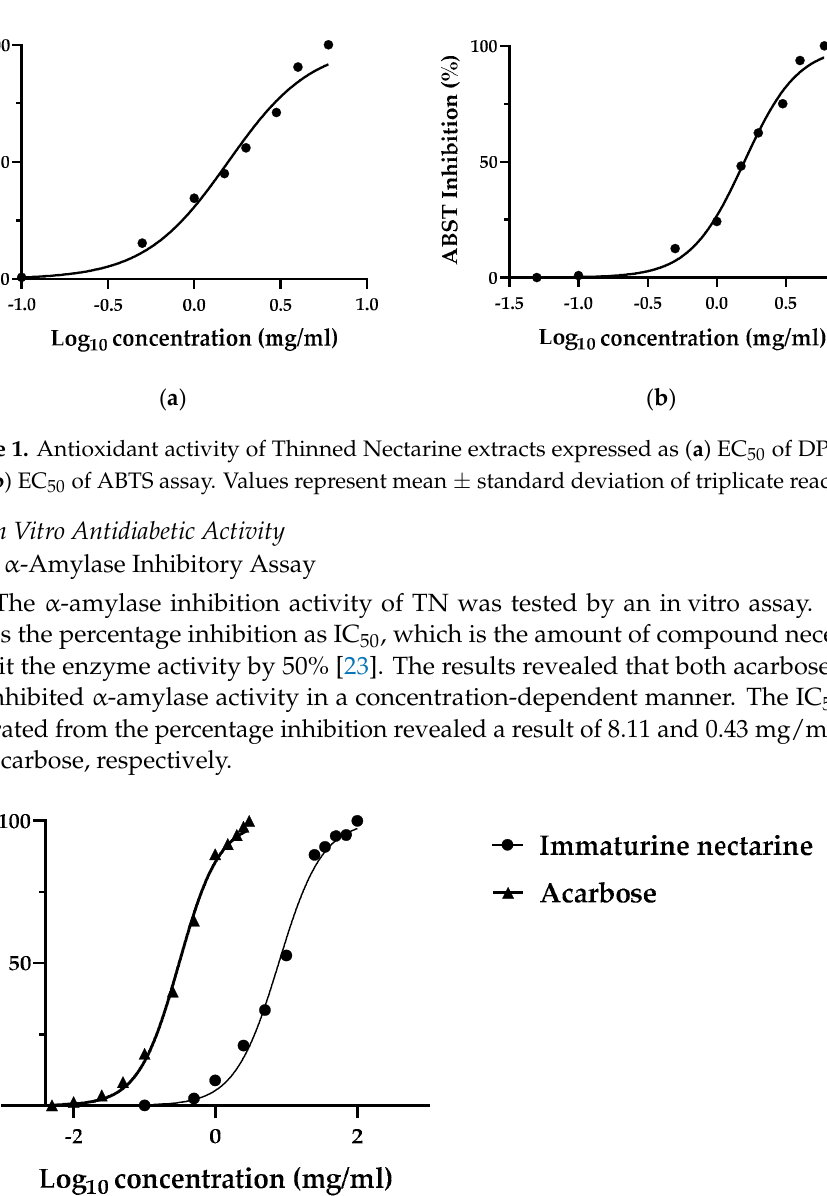
Figure 1. Antioxidant activity of Thinned Nectarine extracts expressed as ( a ) EC 50 of DPPH assay and ( b ) EC 50 of ABTS assay. Values represent mean ± standard deviation of triplicate readings.